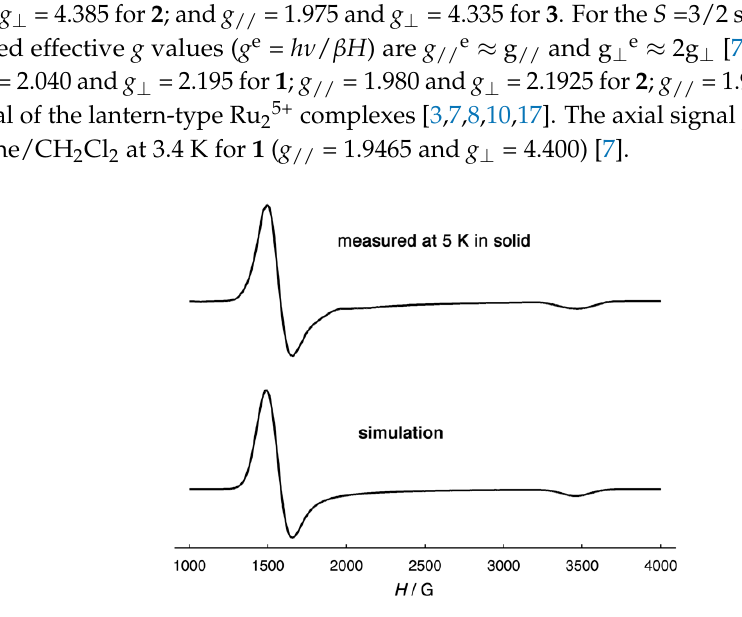
Figure 9. Diffuse reflectance spectra of 1 ( — ), 2 ( — ), and 3 ( — ).